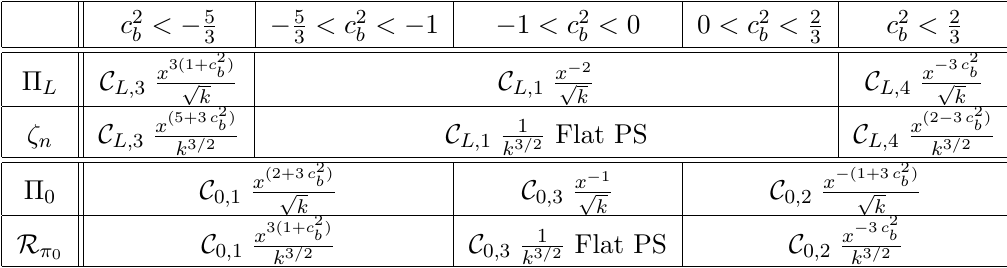
for different values of c 2 0